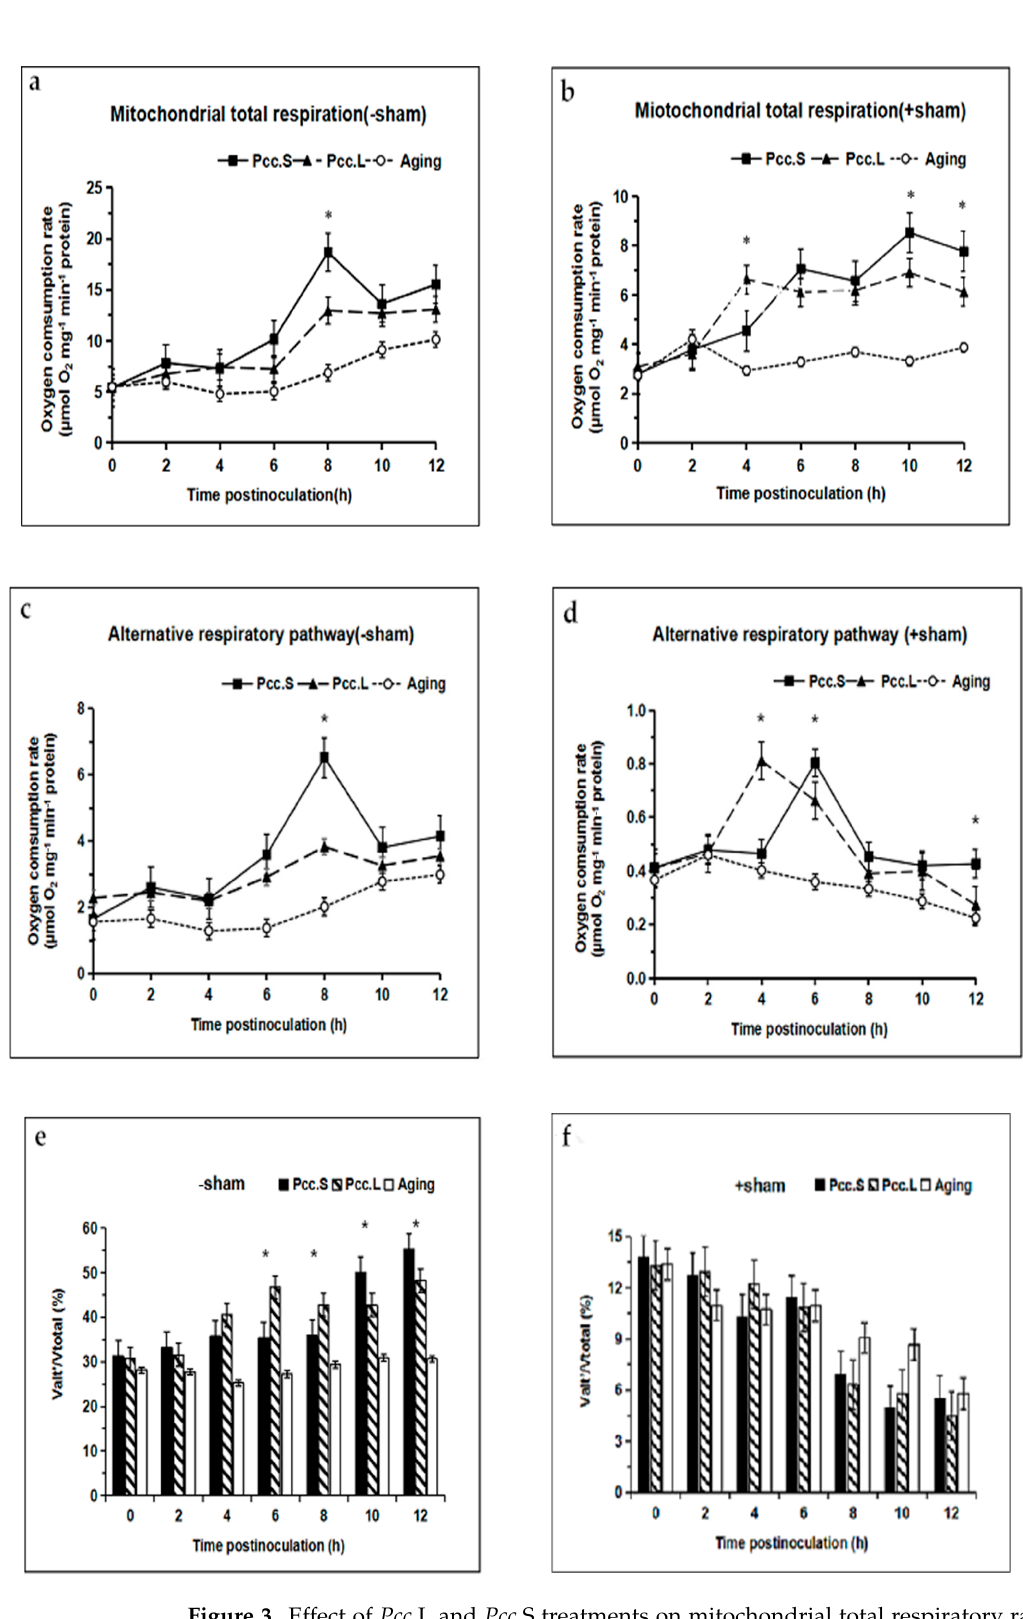
Figure 3. Effect of Pcc .L and Pcc .S treatments on mitochondrial total respiratory rate, alternative respiratory rate and Valt’/Vtotal of tuber slices in no salicylhydroxamic acid treated group ( a , c , e ) and those of the salicylhydroxamic acid pretreated group ( b , d , f ). Aging indicates naturally aged potato tuber slices as control. Bars with * ( t -test) were significantly different at p < 0.05 between Pcc .S and Pcc .L. The standard errors (Vertical bars) of three replicates are